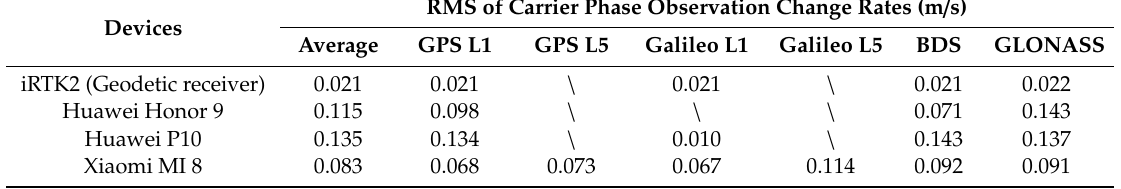
Table 3. The RMS of carrier phase observation change rates of each mobile phone with di ff erent global navigation satellite system (GNSS) systems, where L1 and L5 denote carrier phase observations of two frequencies L1 / E1 and L5 /